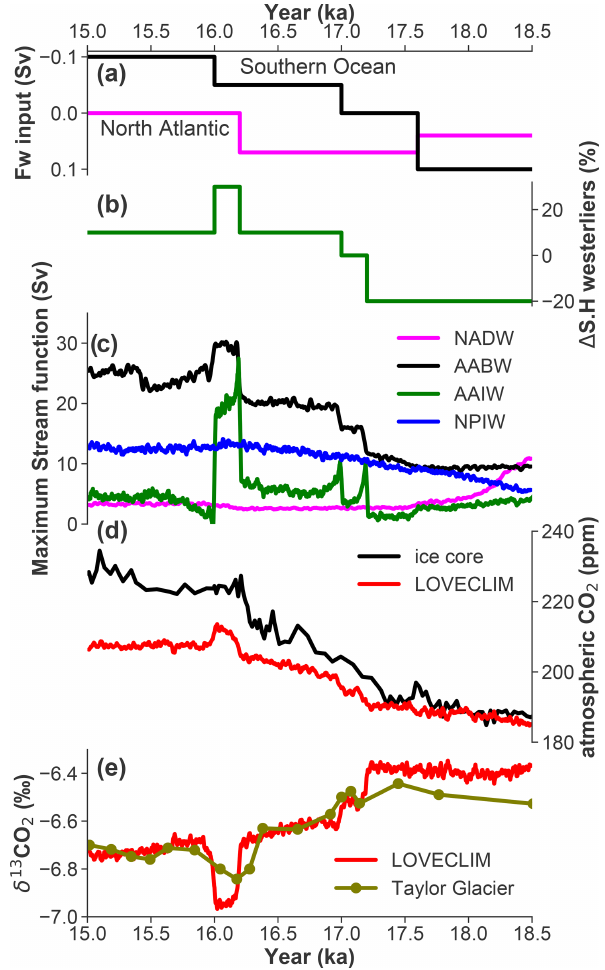
Figure 2. Time series from the LOVECLIM transient experiment (Menviel et al., 2018). (a) Freshwater input into the North Atlantic and the Southern Ocean. (b) Southern Hemisphere westerly wind forcing. (c) Simulated NADW, AABW, AAIW, and NPIW maxi- mum stream function in LOVECLIM; 21-year moving averages are shown for the maximum stream function to filter the high-frequency variability. (d) Ice core record of atmospheric CO 2 (Bereiter et al., 2015; Marcott et al., 2014) and LOVECLIM-simulated atmospheric CO 2 . (e) The Taylor glacier δ 13 CO 2 record (Bauska et al., 2016) and LOVECLIM-simulated δ 13 CO 2